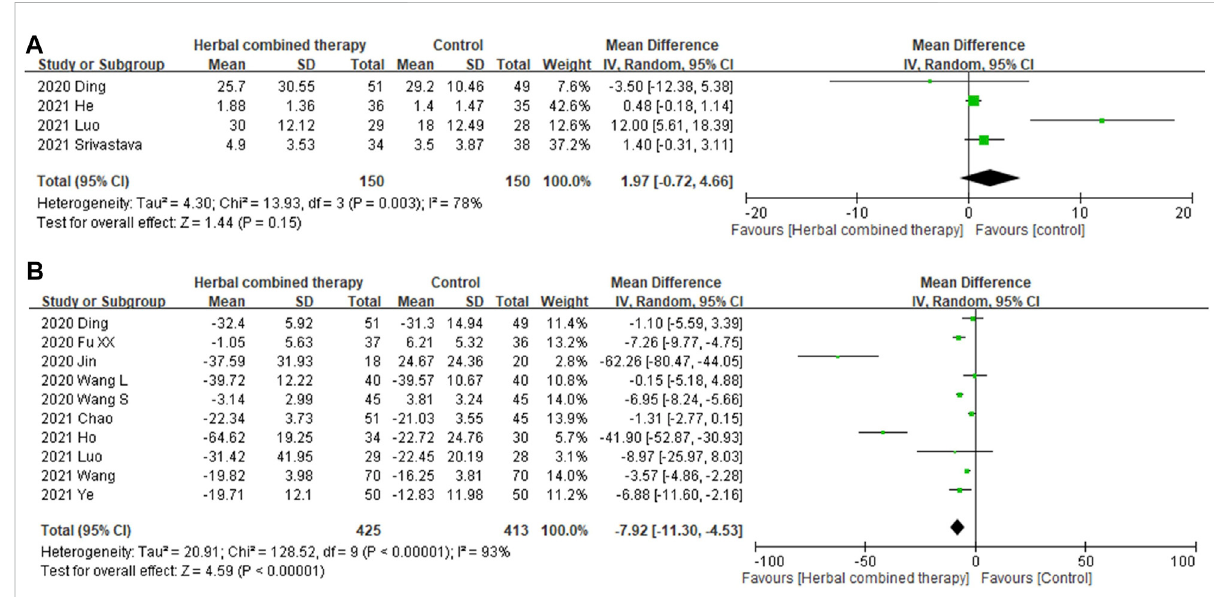
FIGURE 7 (A) : Forrest plot of the effects of HM combined therapy in interleukin-6 (ng/ml) in COVID19 patient. (B) : Forrest plot of the effects of HM combined therapy in C-reactive protein (ng/ml)in COVID19